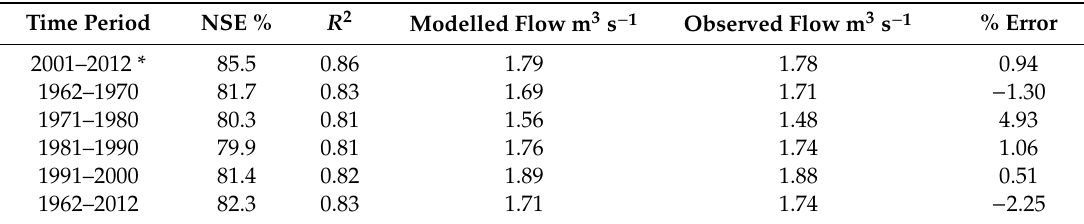
Table 2. Model performance during the calibration and validation stages of the Frome streamflow. Time Period